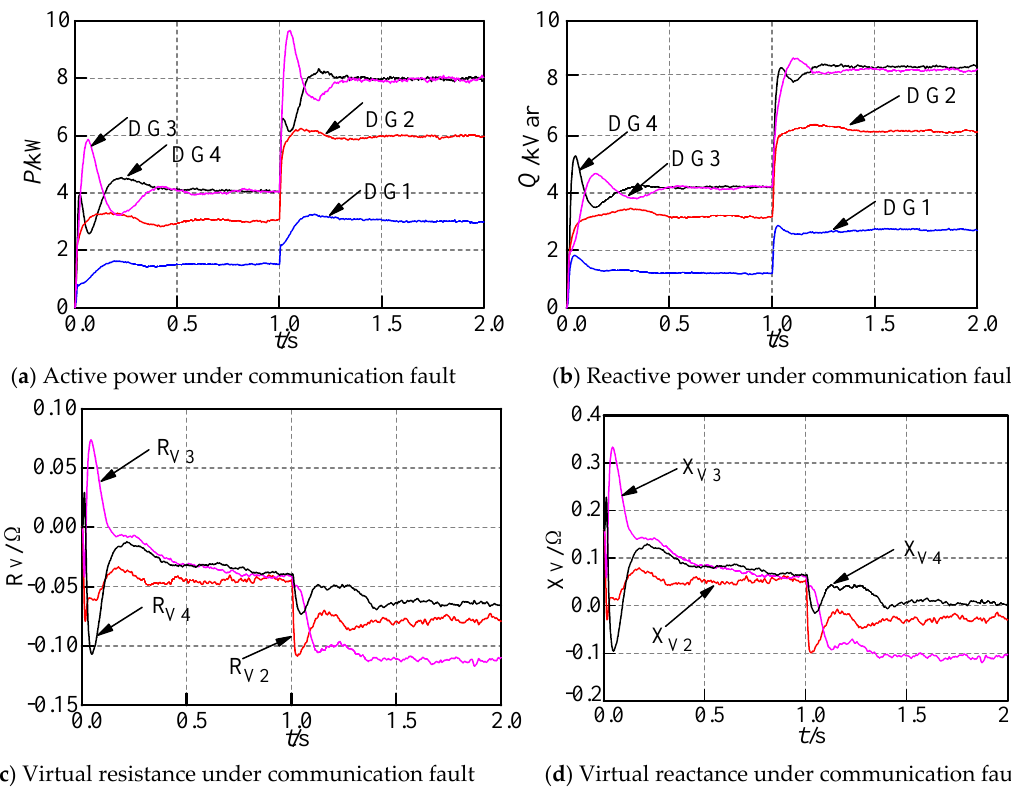
Figure 15. Performance of the proposed control strategy during a communication failure.